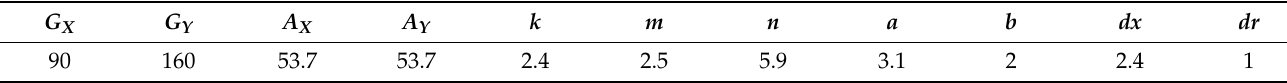
Table 1. Parameters of the antenna arrays (dimensions in mm).